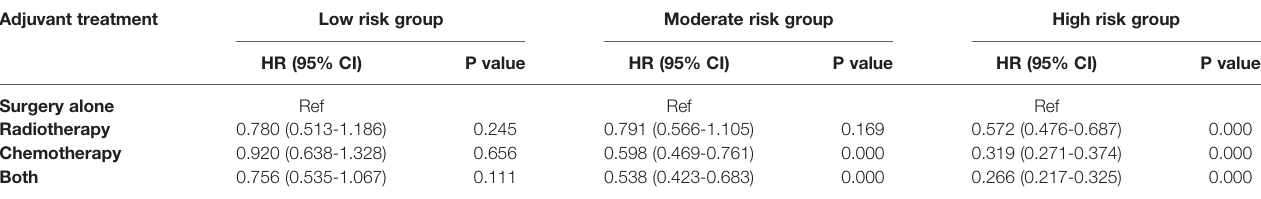
TABLE 3 | Univariate analysis evaluating the effect of adjuvant treatment strategies strati fi ed by subgroups. Adjuvant